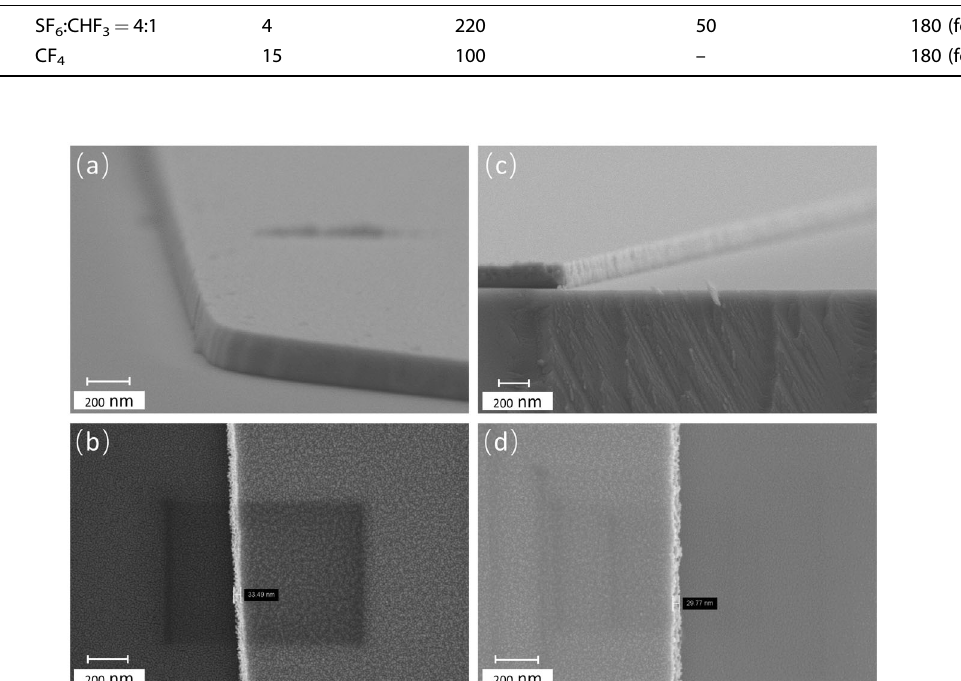
Fig. 7 Four SEM images of Ta fi lm after dry etching. Panels a and b show different angles of the same sample, which was etched in RIE etcher using CF 4 gas. Same for c and d , but SF 6 :CHF 3 mixed gases were used in the ICP etcher. The measured widths of the fi lm edge of both samples are around 30 nm. In c , the horizontal edge is the interface between the substrate and the above metal and air, and the thinner oblique edge is for the tantalum fi